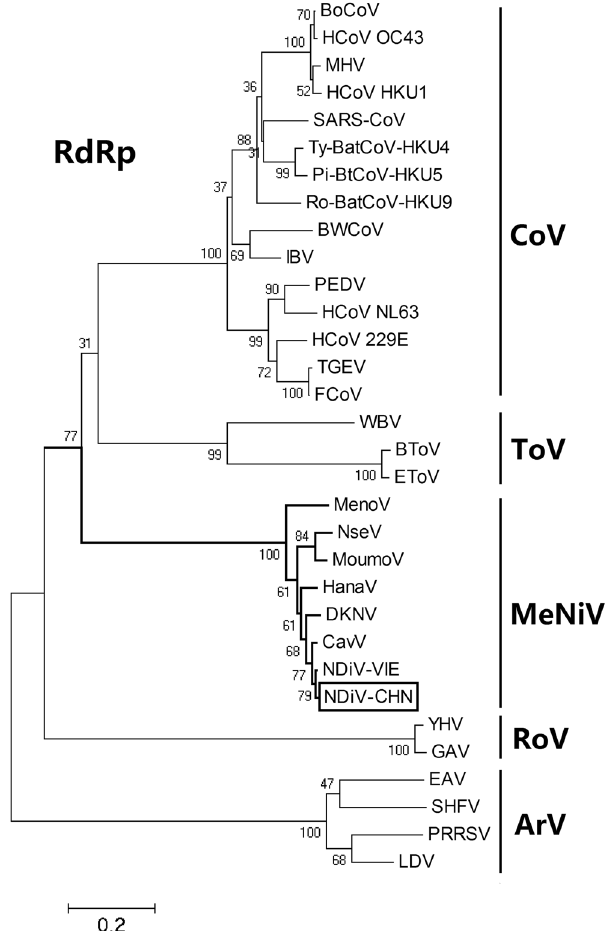
Figure 2. Phylogenetic analysis of nidoviruses based on the deduced amino acid sequences of RdRp domains. The phylogenetic tree was produced by the neighbor-joining (NJ) method and constructed with 1,000 bootstrap replications. The scale indicates the number of amino acid substitutions. The tree was rooted using the arterivirus branch. The GenBank/Refseq accession numbers of the nidovirus species are as follows: BoCoV, bovine coronavirus (NC_003045); HCoV OC43, human coronavirus OC43 strain ATCC VR-759 (AY585228); MHV, murine hepatitis virus strain A59 (AY700211); HCoV HKU1, human coronavirus HKU1 genotype